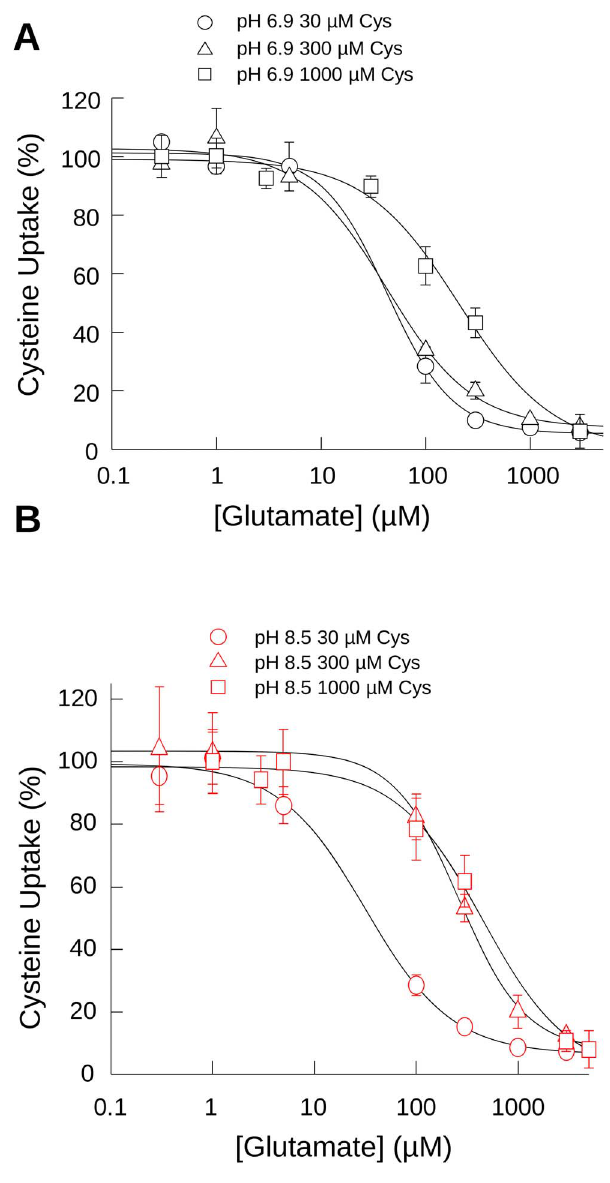
Figure 4. pH affects glutamate inhibition of cysteine transport. Glutamate inhibition of cysteine uptake from oocytes expressing EAAT3 at three different cysteine concentrations: 30 m M (circles), 300 m M (triangles) and 1 mM (squares) at pH 6.9 ( A ) and pH 8.5 ( B ).